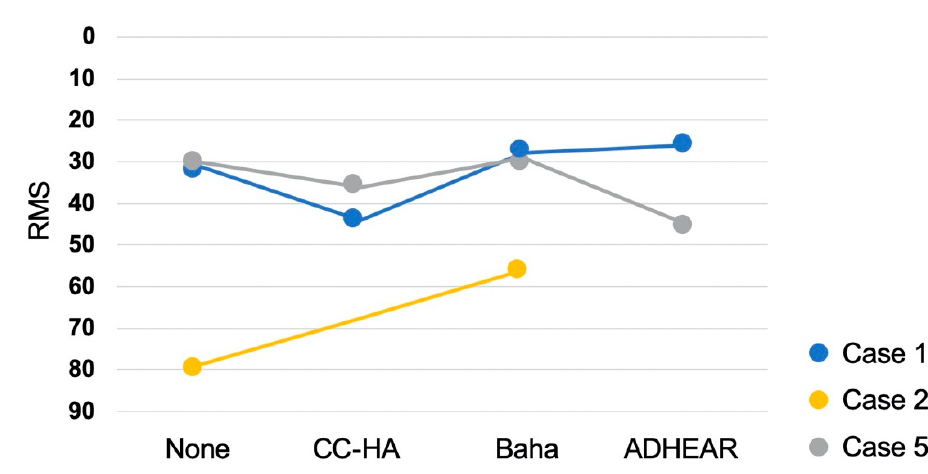
Figure 5. The root mean square (RMS) value of each device.